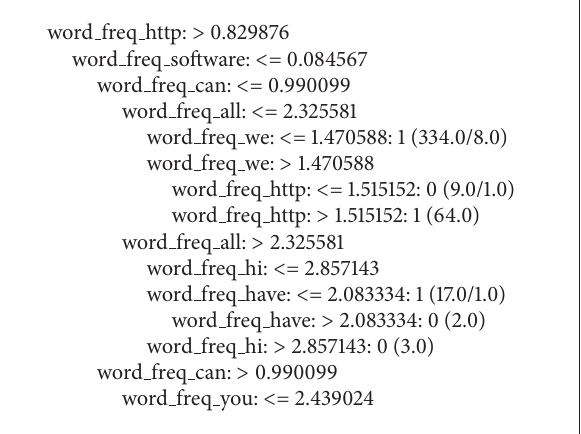
Algorithm 3: Part of C4.5 classification